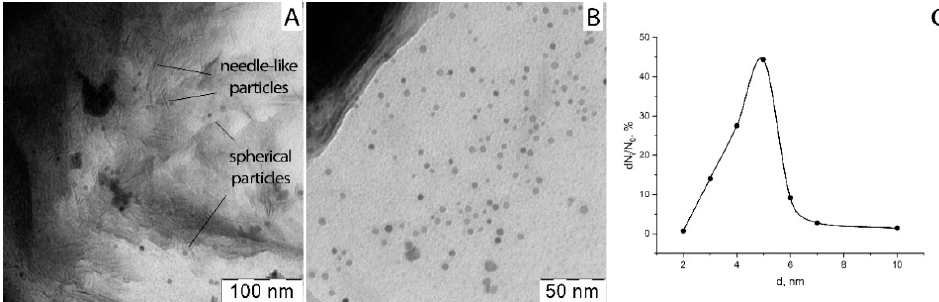
Figure 5. ( A , B )—TEM microphotographs of ultra-thin sections of composite PVP-HA (sample 1, Table 1) at different magnifications; ( C )—HA particle size distribution.